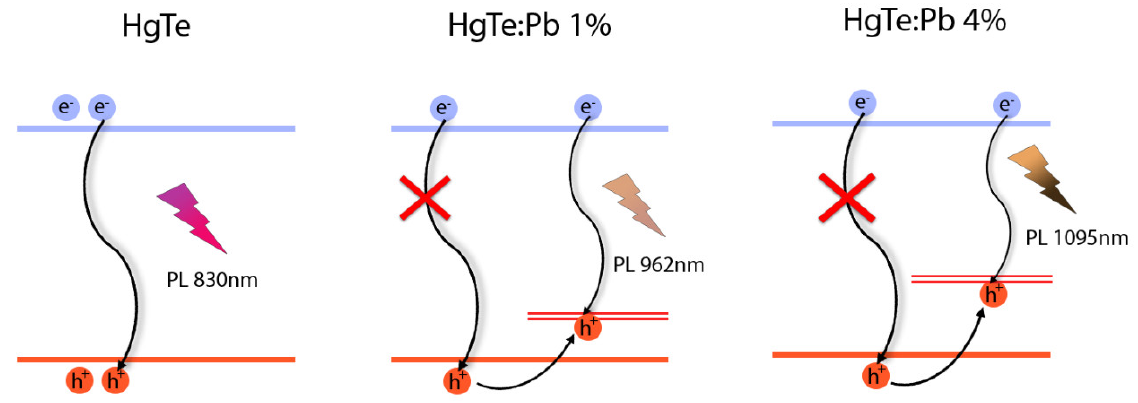
Figure 5. The scheme of the energy relaxation in the HgTe:Pb NPLs.